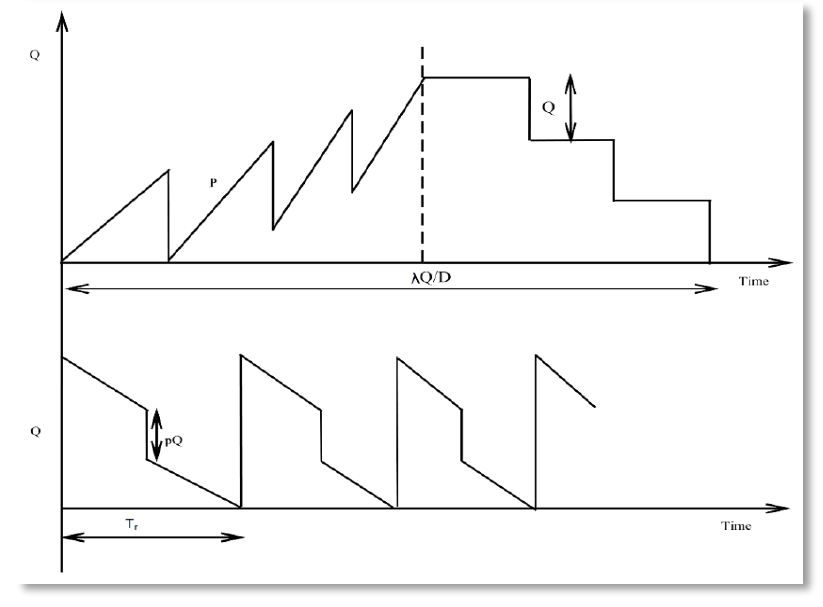
Figure 1. The basic model for vendor and